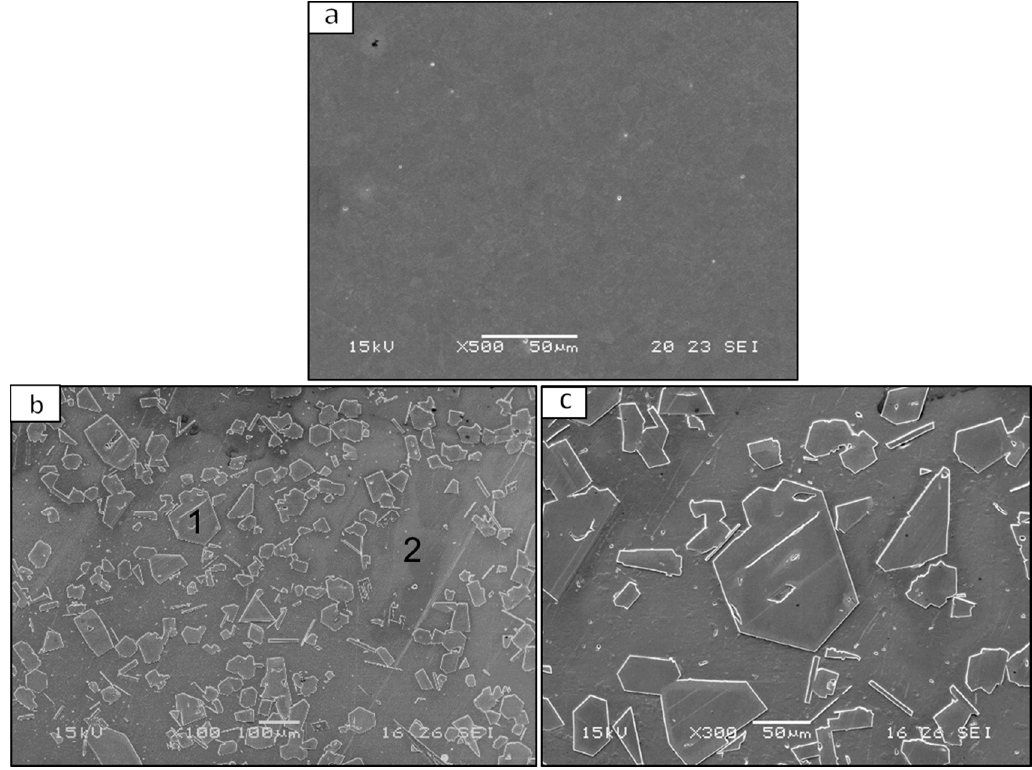
Figure 1. Microstructure at cross-section of ( a ) Pure Zn. ( b , c ) Zn–1.3Fe alloy, macro and close-up view respectively. Table 2. Chemical composition of Zn–1.3Fe at different points shown in Figure 1b.